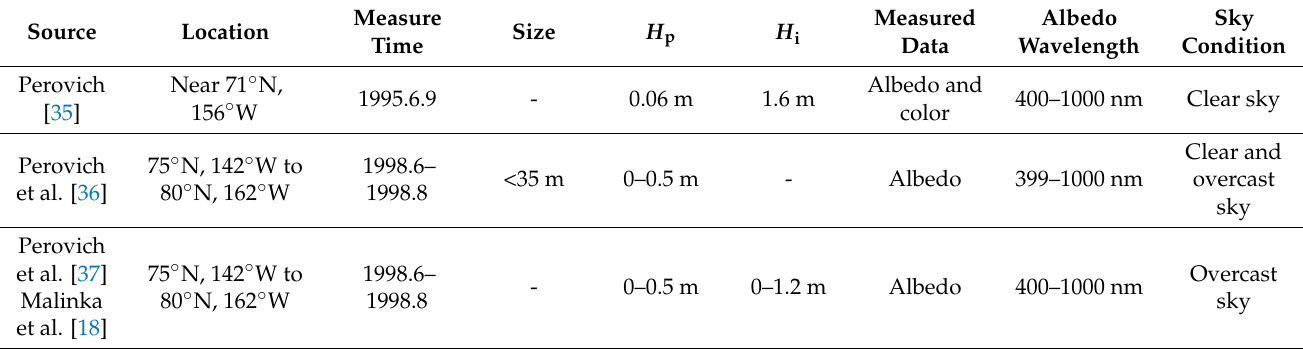
Table 1. The eight datasets including different sky